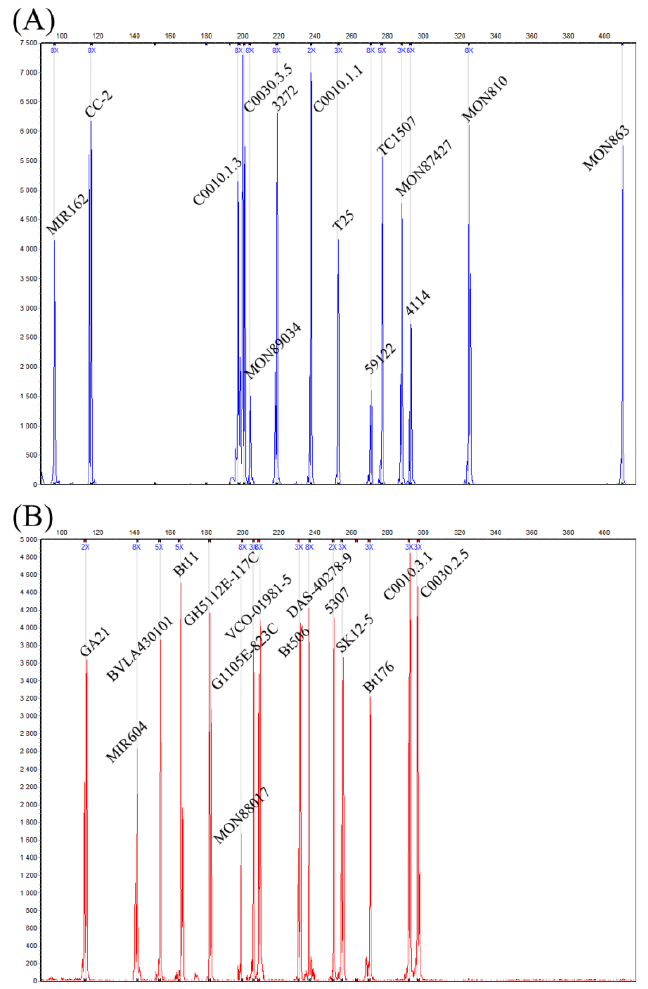
Figure 1. Capillary electrophoretograms from simplex PCR and multiplex electrophoresis assays. The x- and y-axes represent amplified fragment length and fluorescence intensity, respectively. ( A , B ) Results obtained using FAM-labeled ( A ) and ROX-labeled ( B )